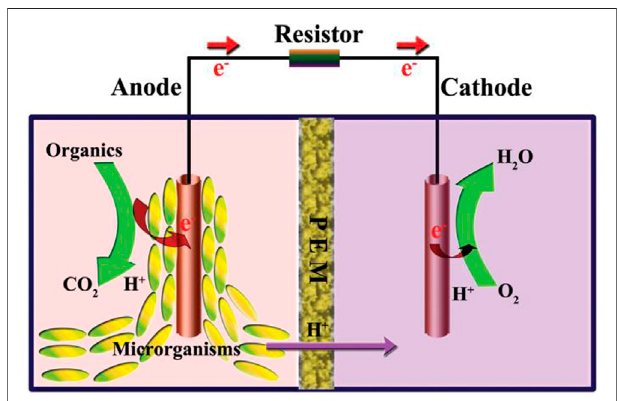
FIGURE 2 | Schematics of double chambered microbial fell cells (Zhao et al.,